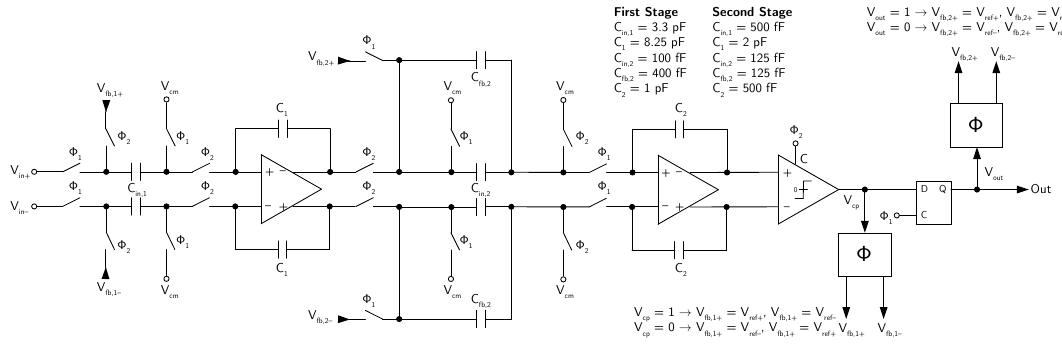
Figure 16. Schematic of the SC implementation of a single stage of the reconfigurable DT MASH ΣΔ modulator (example